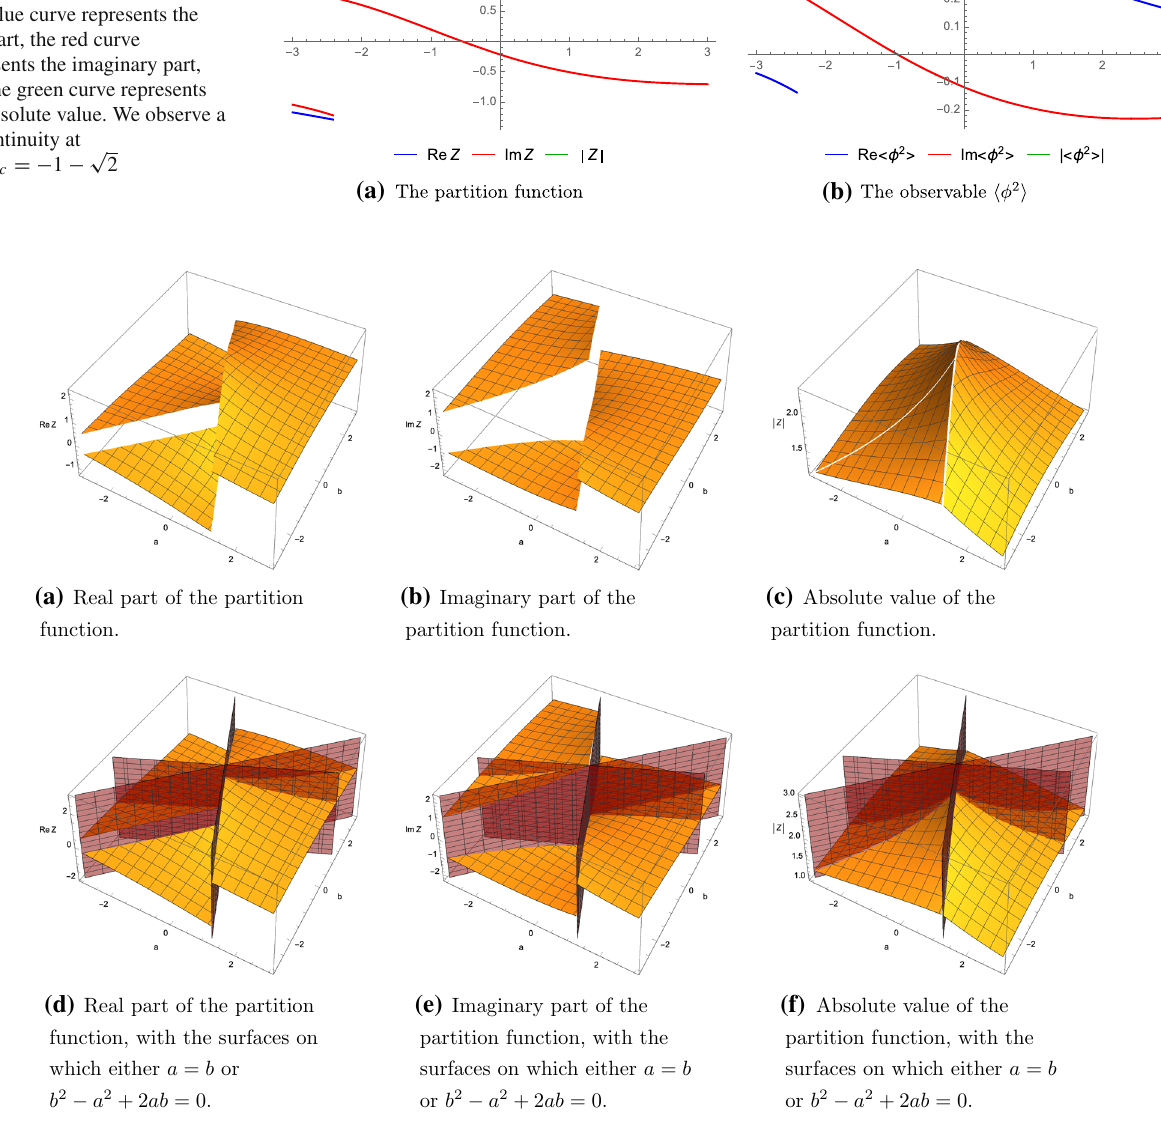
Fig. 10 The partition function Z and observable (cid:2) φ 2 (cid:3) as a function of b for the parameters { a = 1, c = 1, d = 1, h = 0 } . The blue curve represents the real part, the red curve represents the imaginary part, and the green curve represents the absolute value. We observe a discontinuity at